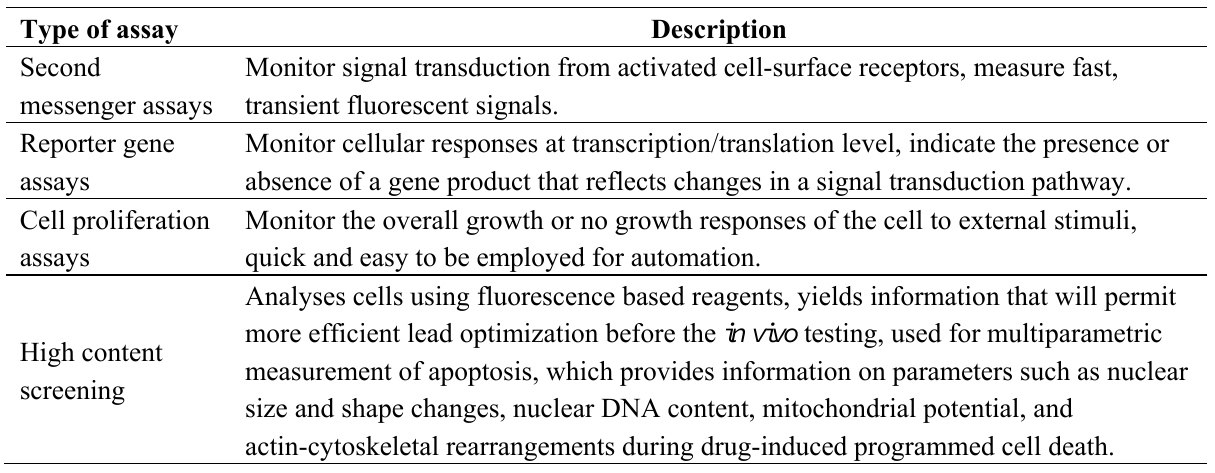
Table 3. Classification of cell-based